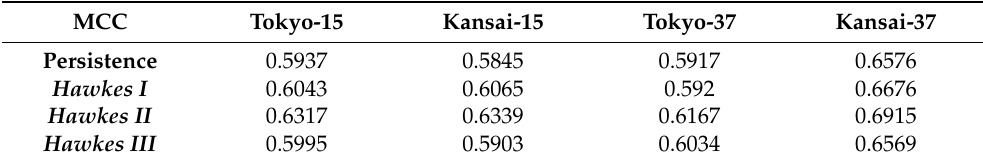
Table 5. Values of Matthews correlation coefficients corresponding to the four investigated